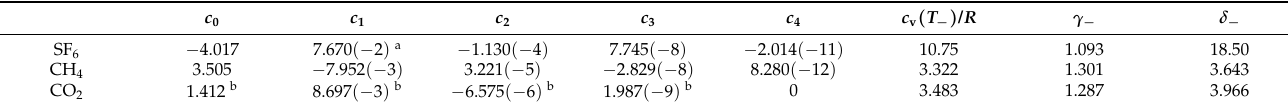
Table 1. The coefficients in the fitting formula (27) and c v ( T − ) , γ − , and δ − for T − = 300K for SF 6 , CH 4 , and CO 2 .